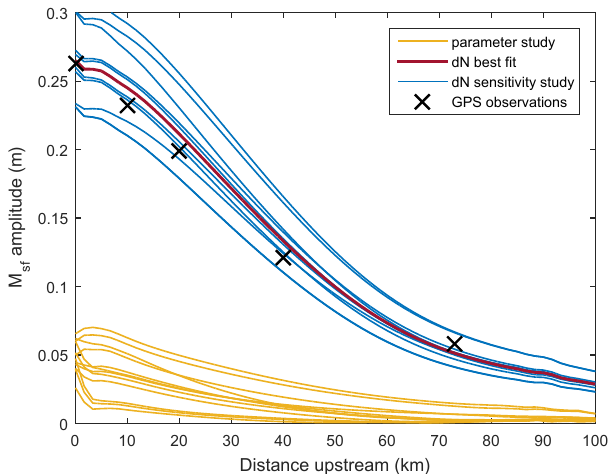
Figure 5. M sf amplitude as a function of distance upstream for pa- rameter study simulations with no hydrology (yellow), compared with GPS measurements (crosses), all results from the coupled model sensitivity study (blue) and the coupled model best fit to GPS data (red).